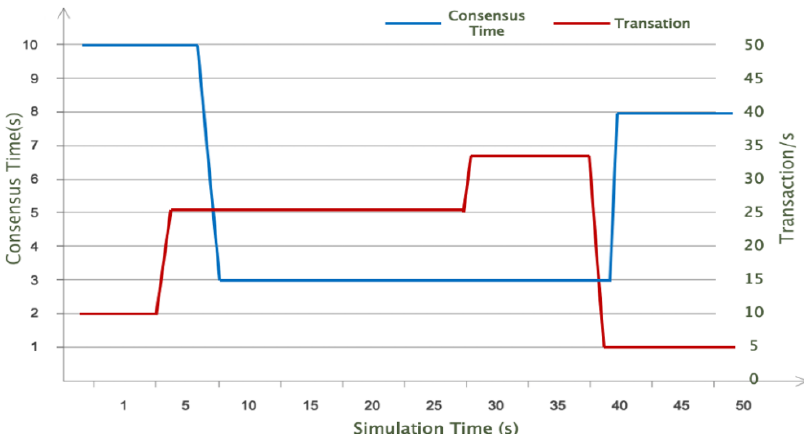
Figure 7. Dynamic regulation of blockchain utilization efficiency .